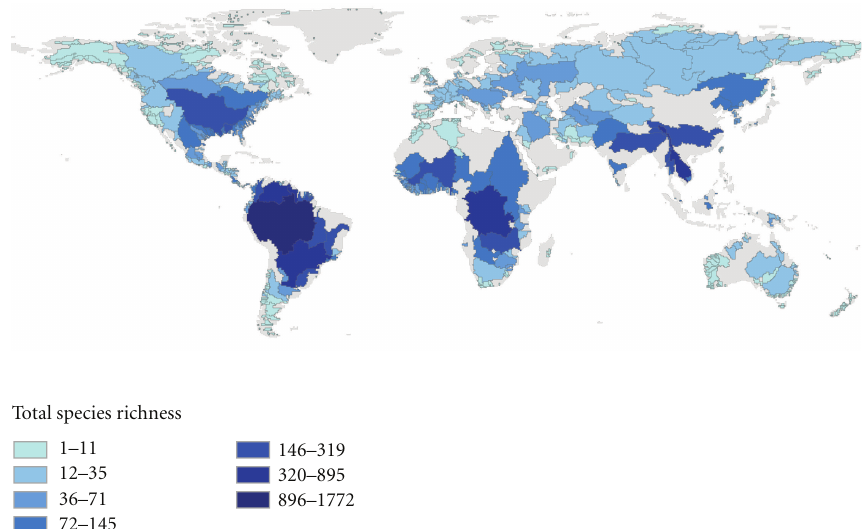
Figure 1: Global freshwater fish species richness patterns at the drainage basin